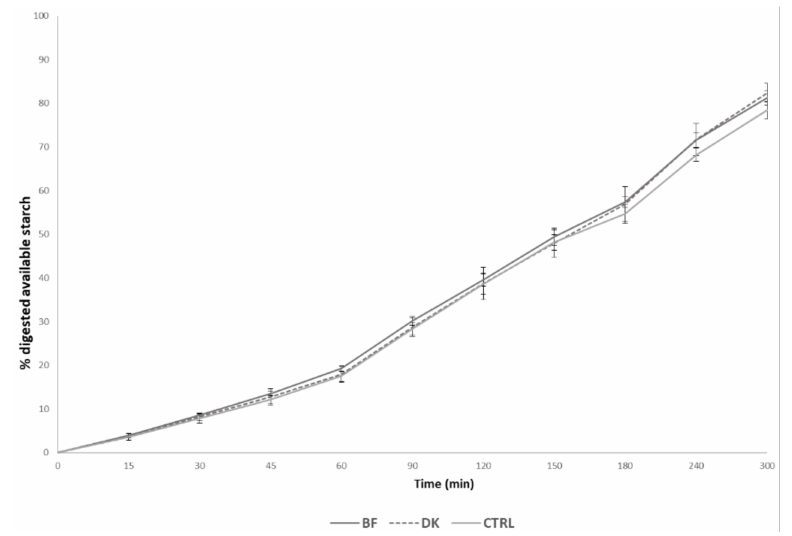
Figure 1. Lines represent the digested starch reported as a percentage of the total available starch during the in vitro digestion of each test food. Values are reported as the mean ± standard deviation (SD) ( n = 3). BF: pasta produced by enriching semolina with a durum wheat bran fraction; CTRL: control, pasta produced by traditional milling; DK: pasta produced by using micronized debranned kernels. Statistical analysis was performed via one-way ANOVA and Bonferroni post hoc testing ( p <